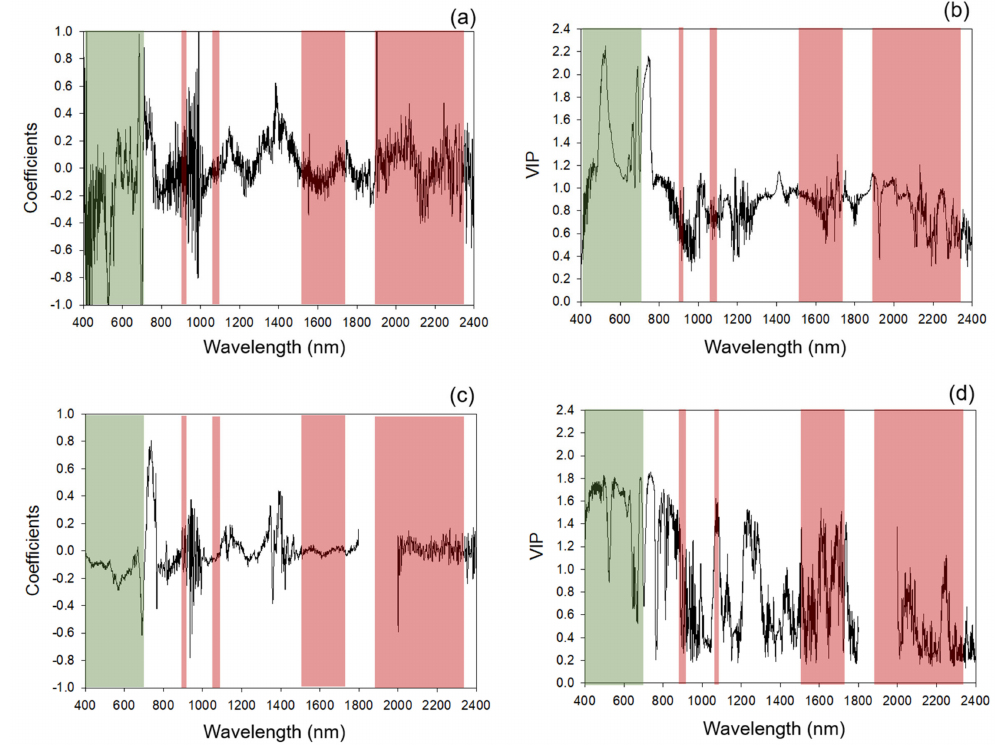
Figure 5. Multi-year models: standardized coefficients and variable importance for the projection (VIP) selection for multi-year models. ( a , c ) Standardized coefficients of the multi-year models for leaf-level and canopy-level measurements, respectively; ( b , d ) VIP of the multi-year models for leaf-level and canopy-level measurements, respectively. Shaded areas: absorption features present between 400 and 2400 nm for chlorophyll (green) and protein (red). Specific absorption features within these regions listed in Appendix C Table